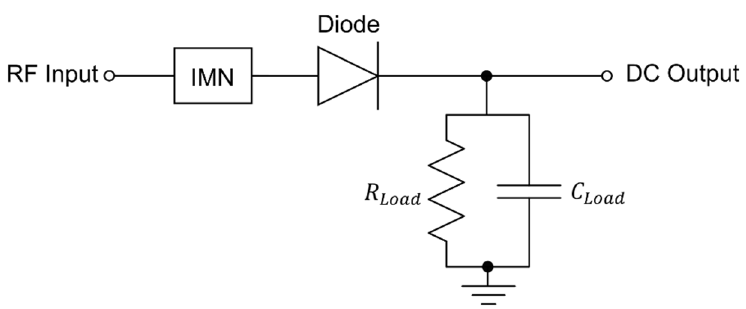
Figure 5. Simplified block scheme of the designed power detector.